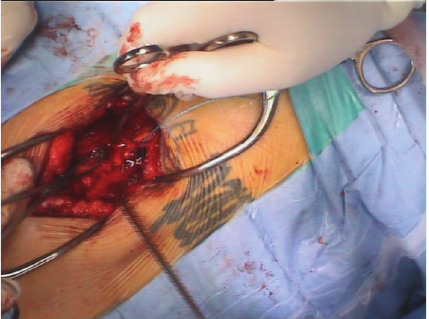
Figure 5: Intraoperative image of the bullet inside the spinal canal before the